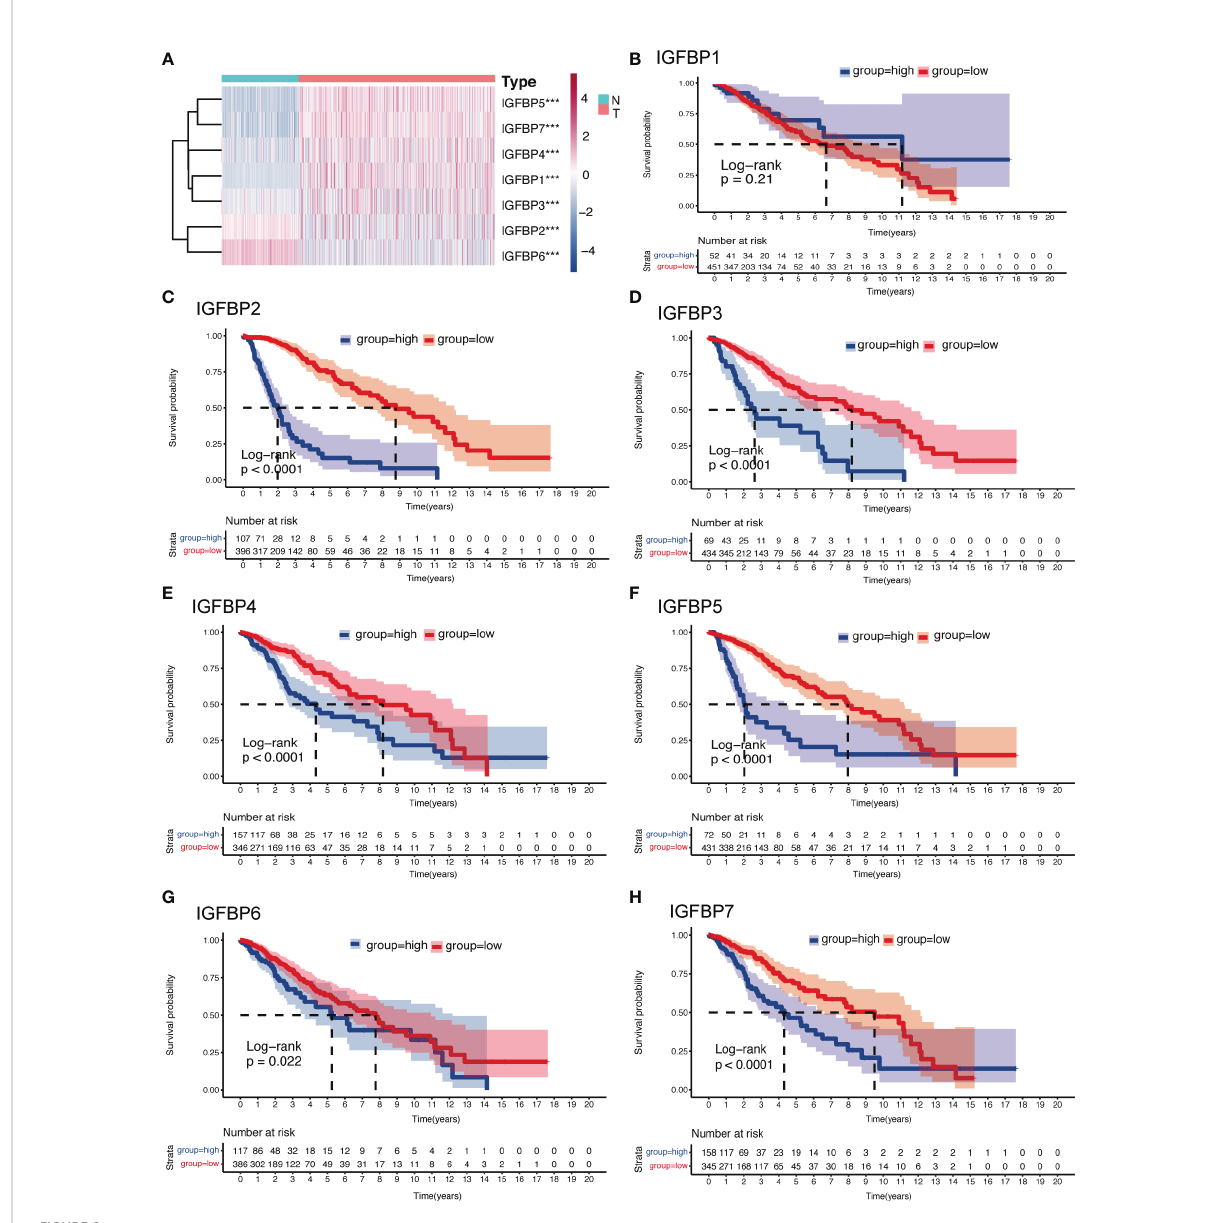
FIGURE 2 Expression and survival analysis of the IGFBP family of gliomas. (A) Heatmap of differential expression analysis of IGFBP family between normal cortex and the TCGA glioma cohort. (B – H) Kaplan – Meier survival analysis was performed using the optimal cutoff value to distinguish the IGFBP genes between high and low subgroups in the TCGA glioma cohort. For all experiments,